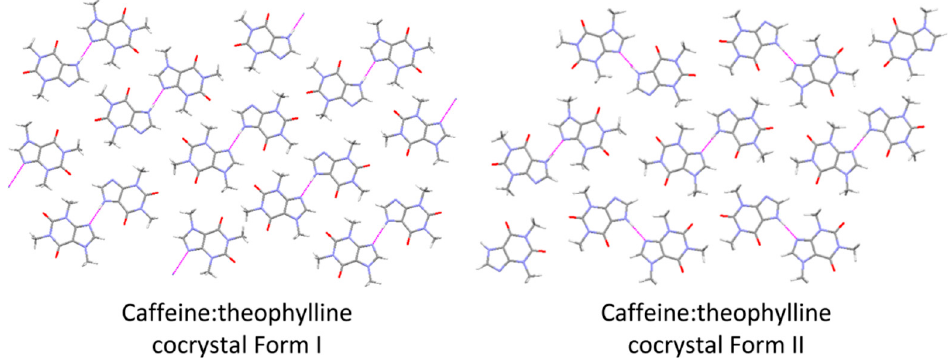
Figure 13. Hydrogen bonded dimer of caffeine and theophylline in two respective caffine-theophylline cocrystal polymorphs. Adapted with permission from Cryst. Growth Des., 2013, 13 (10), 4599–4606. Copyright 2013, American Chemical Society.